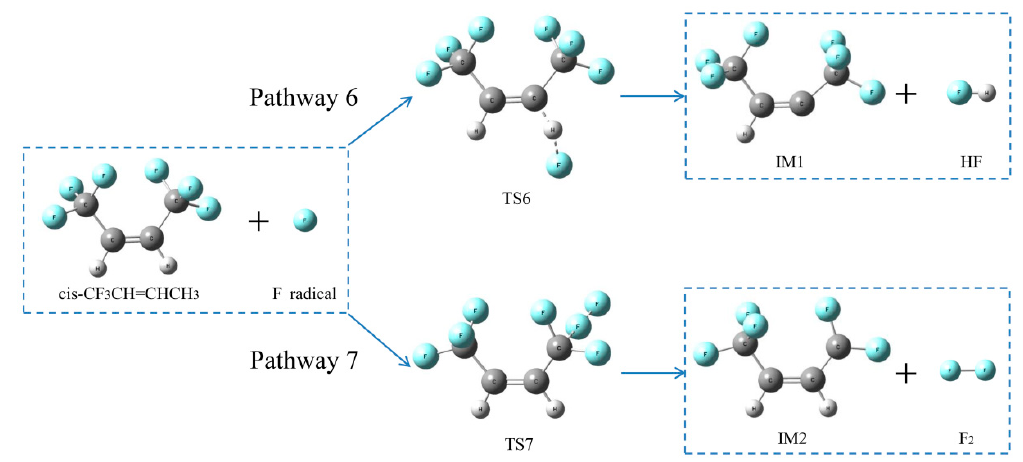
Figure 17. Two proposed pathways for cis ‐ CF 3 CH=CHCF 3 + F• reactions. C, H and F atoms are represented with black, gray and blue balls, respectively.